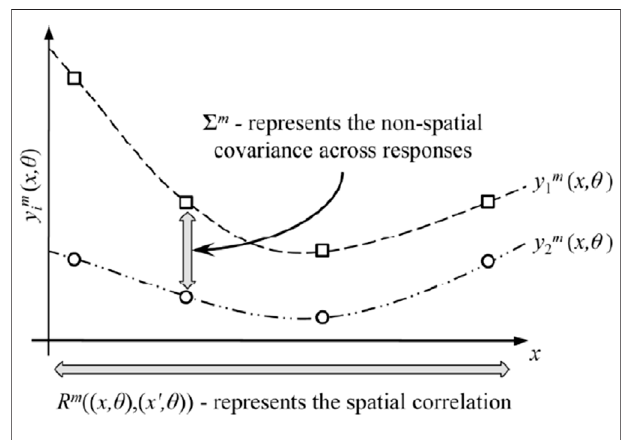
FIGURE 8 | Schematic diagram of MRGP